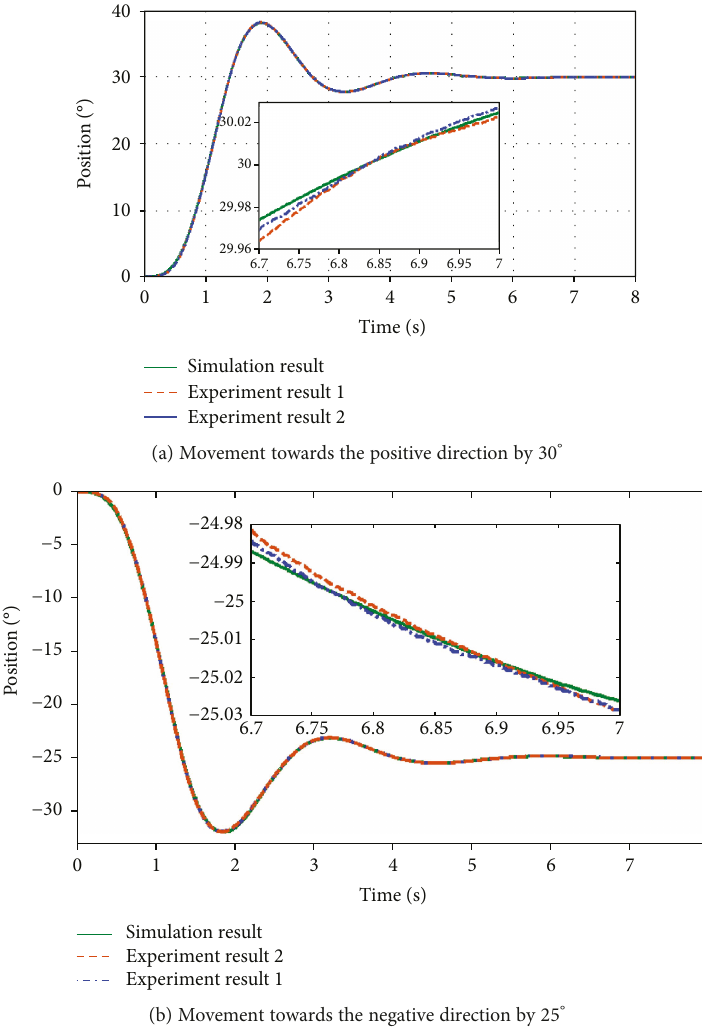
Figure 6: Identi fi ed 6-order system simulation outputs and system actual